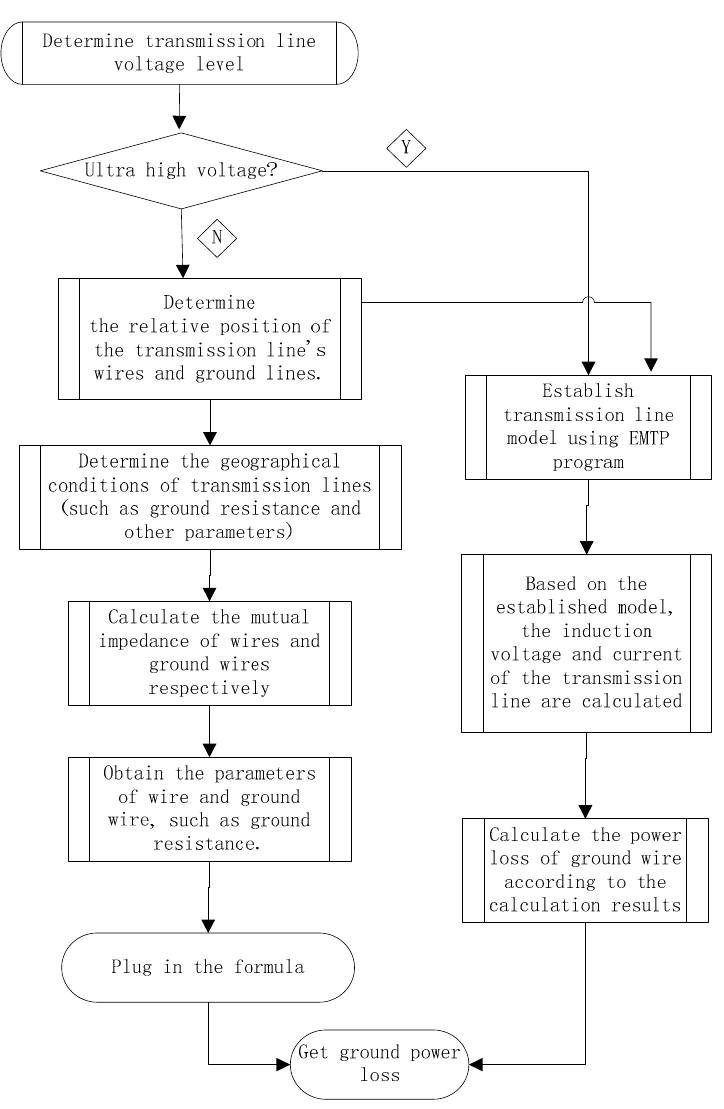
Figure 6. Calculation method of electric energy loss.